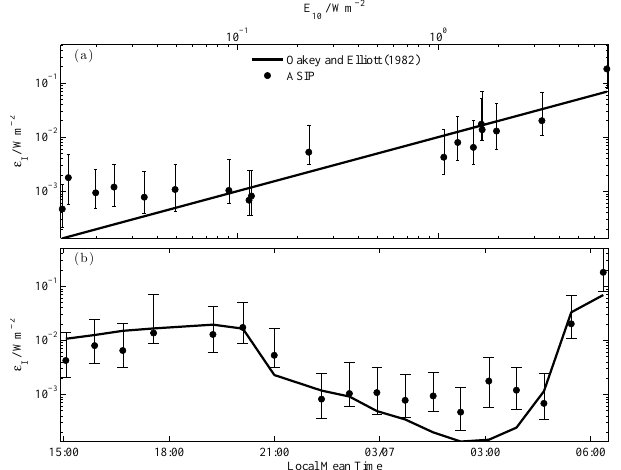
Fig. 11. Depth integrated dissipation rate in the OBL as a function of wind speed at 10m. (a) shows the integrated dissipation as a function of input wind energy while (b) shows this quantity as a function of local time. The individual profiles are averaged into 1h by 1m bins and the error bars represent the limits of the integrated 95% confident limits as determined with a bootstrap